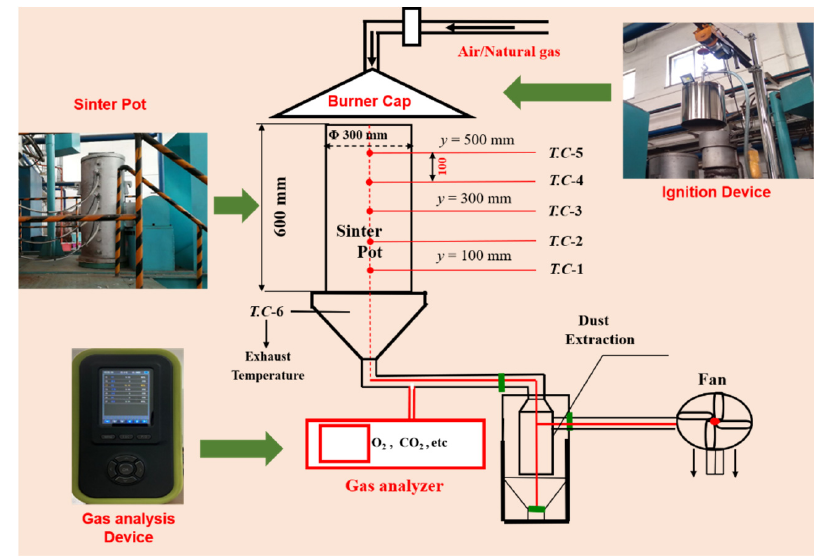
Figure 6. Schematic of the sintering experiments.